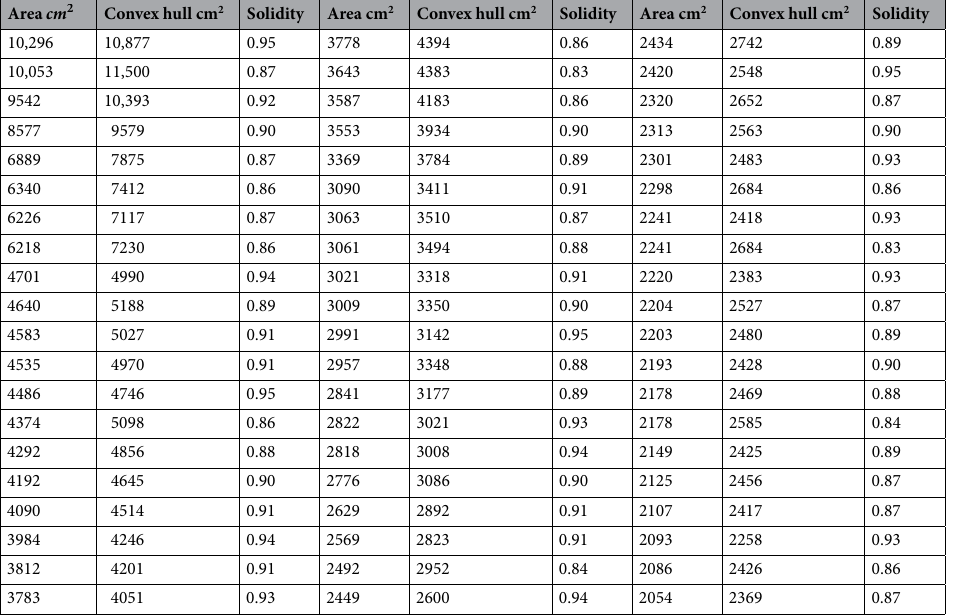
Table 2. Granite rock block